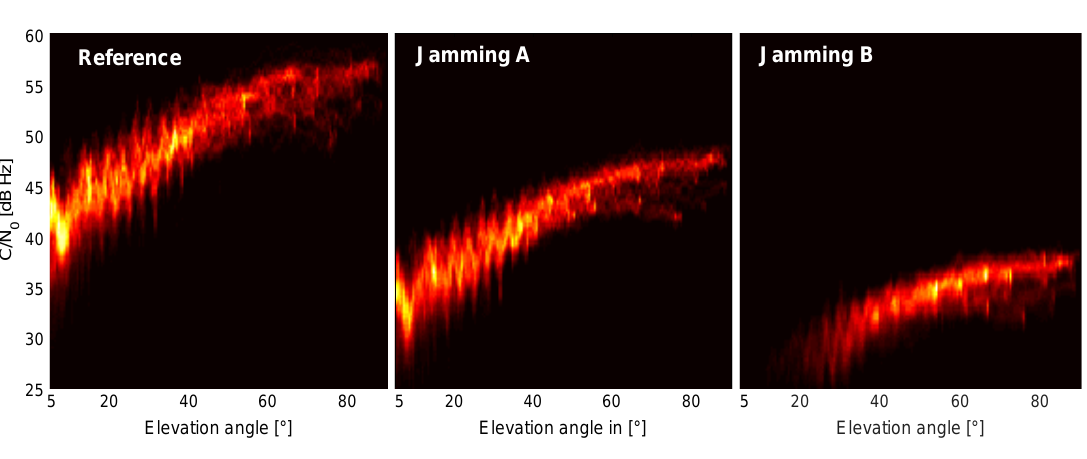
Figure 6. 2D histogram plot of carrier-to-noise density ratio (CN0) versus elevation angle without jamming ( left ); for Scenario A ( middle ) and Scenario B ( right